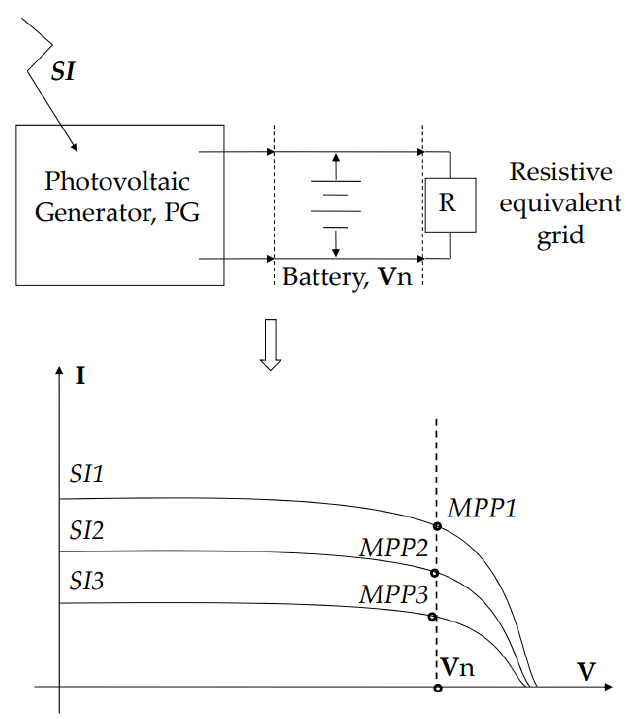
Figure 1. Working point variations of a grid-connected PV generator for different solar irradiance ( SI ) levels in the presence of a battery [25].